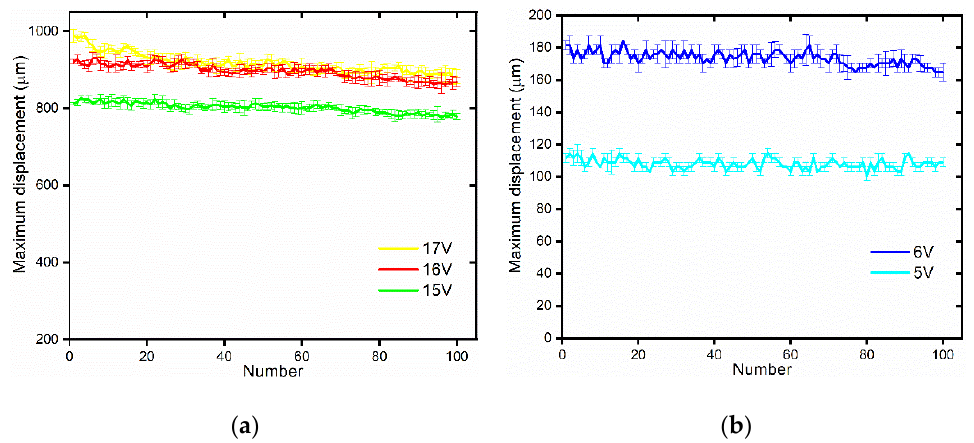
Figure 8. Durability testing of the polyimide electrothermal film. ( a ) Polyimide film with size of 6 mm × 50 mm; ( b ) Polyimide film with size of 6 mm × 22